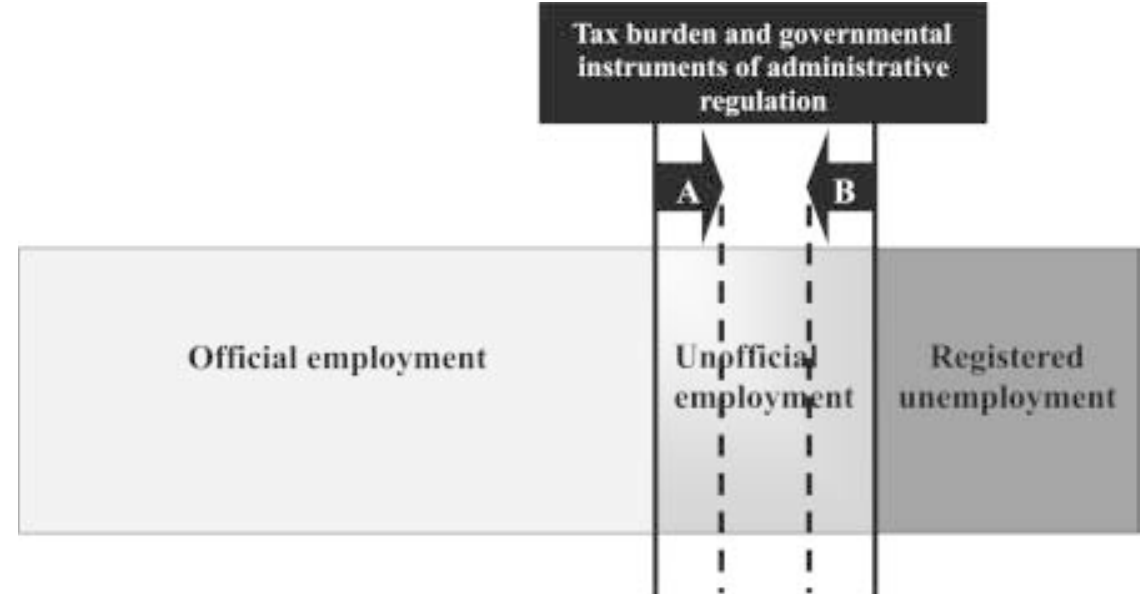
Fig 6. Impact of tax burden and governmental administrative regulation levers on the structure of labour market